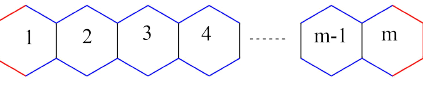
Fig. 2 Graphene sheet G ( 1 , m )